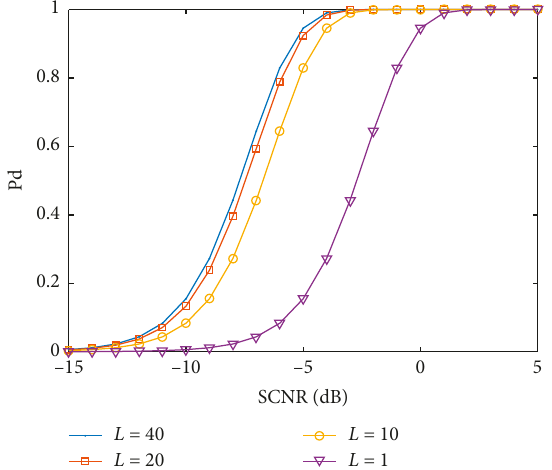
Figure 7: Detection probability versus SCNR. Algorithm 3 for same values of randomizations.